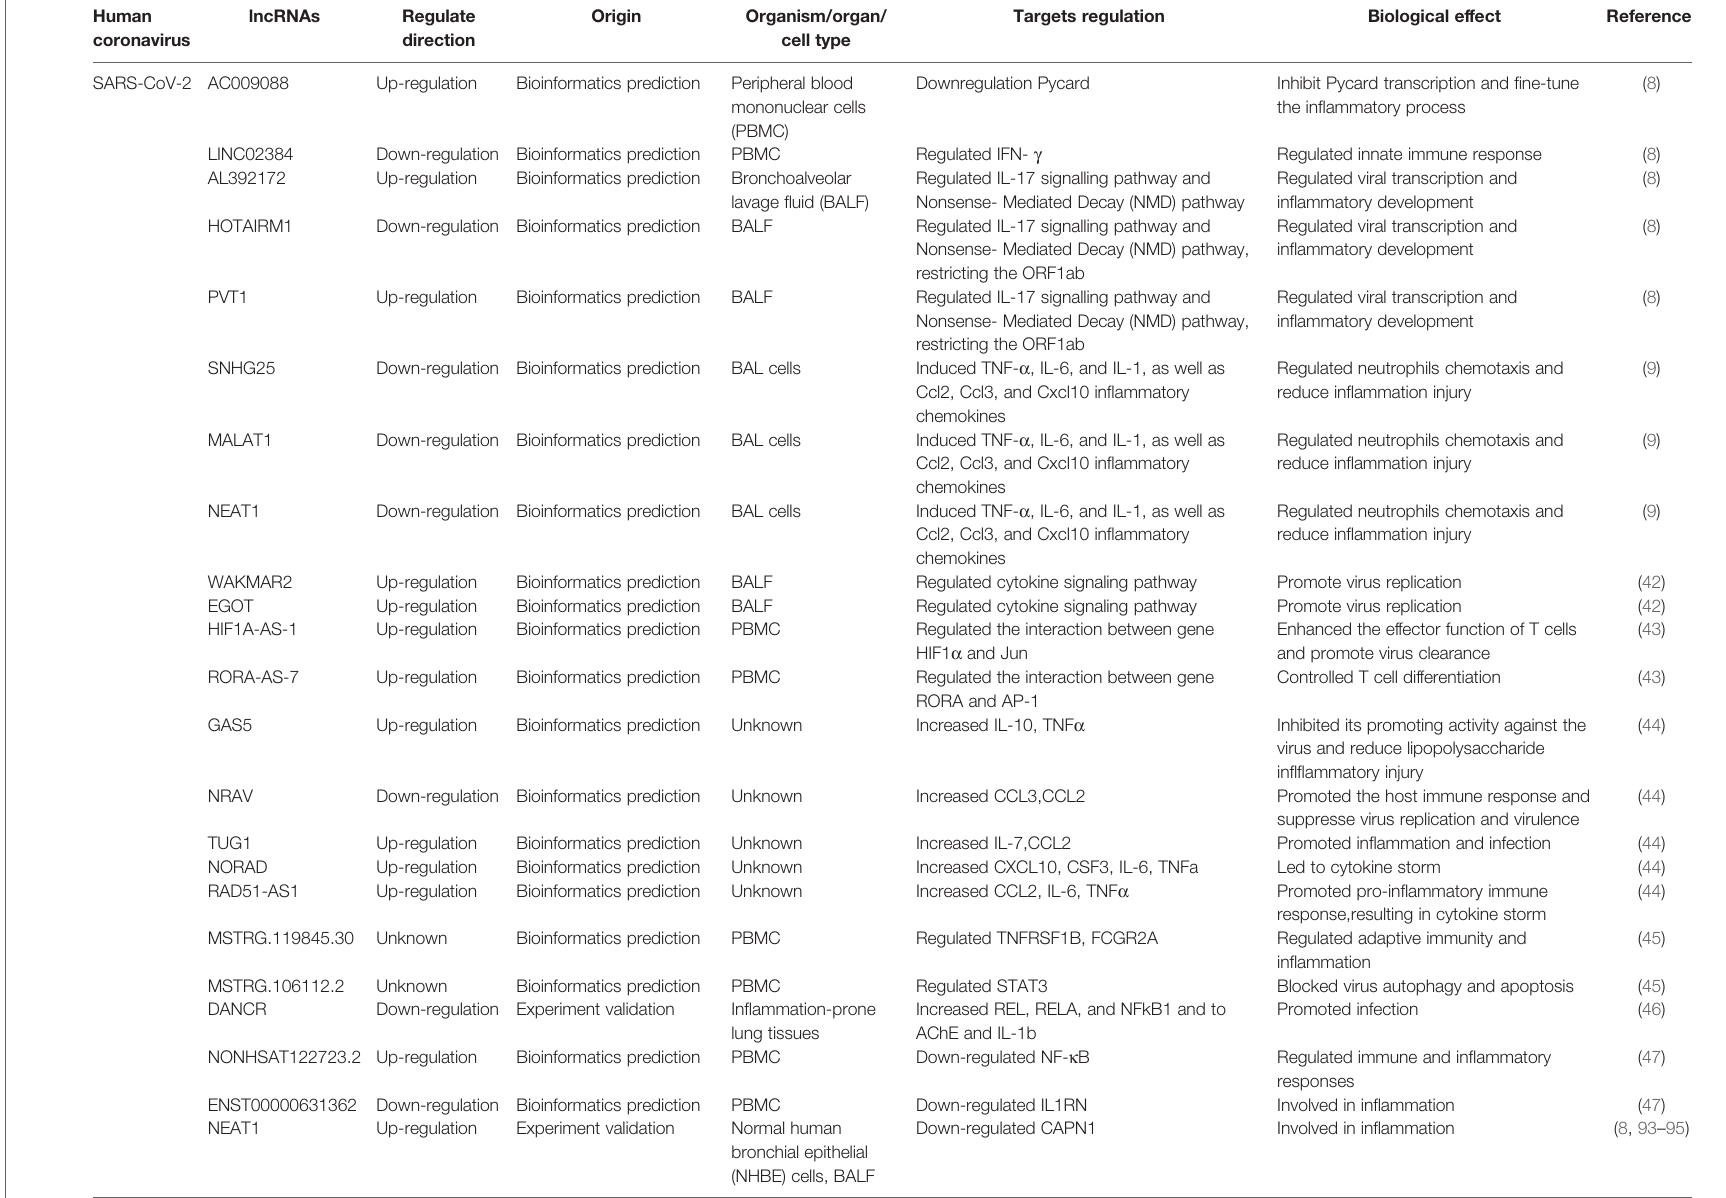
TABLE 2 | Signi fi cant lncRNAs associated with